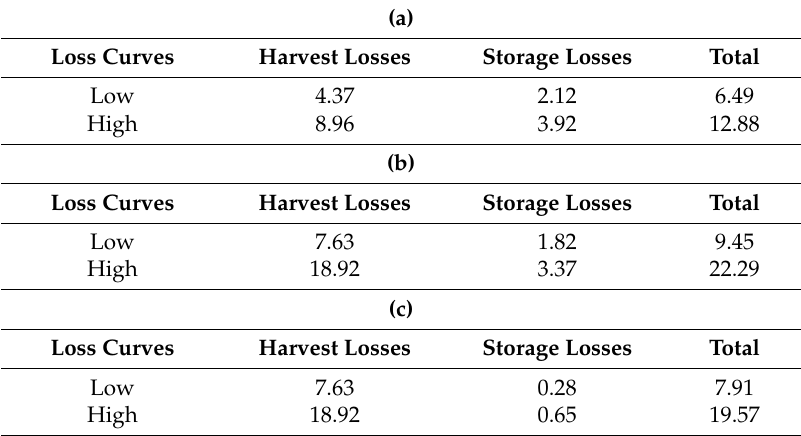
Table 6. ( a ) Cost of losses (USD / Mg biorefinery design capacity) for Scenario 1. ( b ) Cost of losses (USD / Mg biorefinery design capacity) for Scenario 2. ( c ) Cost of losses (USD / Mg biorefinery design capacity) for Scenario